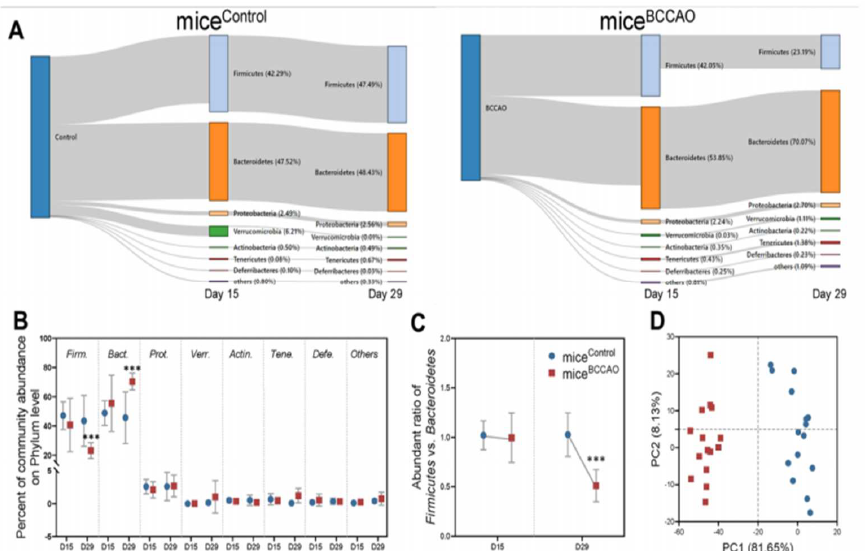
Figure 3. ( A , B ) Metagenomic analysis of mice in BCCAO and control groups showed significant changes in gut microbial composition. ( C ) Firmicutes/Bacteroidetes ratio was reduced in BCCAO vs. control groups on day 29 after FMT. ( D ) The effects of baicalin treatment on the gut microbial populations at the phylum level showed that the plot of principal component 1 against principal component 2 formed a distinct cluster. Phylum clustering in BCCAO group was different from that in the control group. *** p < 0.01. The figure is reused as per journal copyright permission [145].